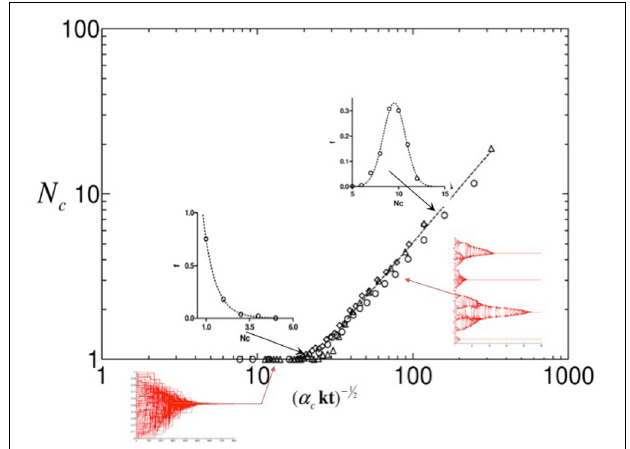
FIGURE 7 | Size effect on system dynamics. The main panel of the figure reports how T/N2 vs. N for dierent values of the parameter (cid:3) O c . The data (cid:5) 1 . 72) clearly indicating that the time of approach a constant value ( T N 2 convergence of the anity matrix scales quadratically with the number of agents, in agreement with the theory. The asymptotic value estimated by our theory is 2 . 19, the discrepancy being therefore quantied in about 15%. and Tc vs. N for (cid:3) Oc = 0 . 5. As predicted by the theory and Left inset: T N 2 N 2 the numerics a crossover is found for groups for which opinions converge slower than the anities: this is the signature of a distinctive dierence in the behavior of small and large groups, numerically we found that this dierence is plotted for two dierent is eective for N (cid:5) 20. Right inset: σ ( k ) vs. t N 2 values of N . As expected the two curves nicely collapse